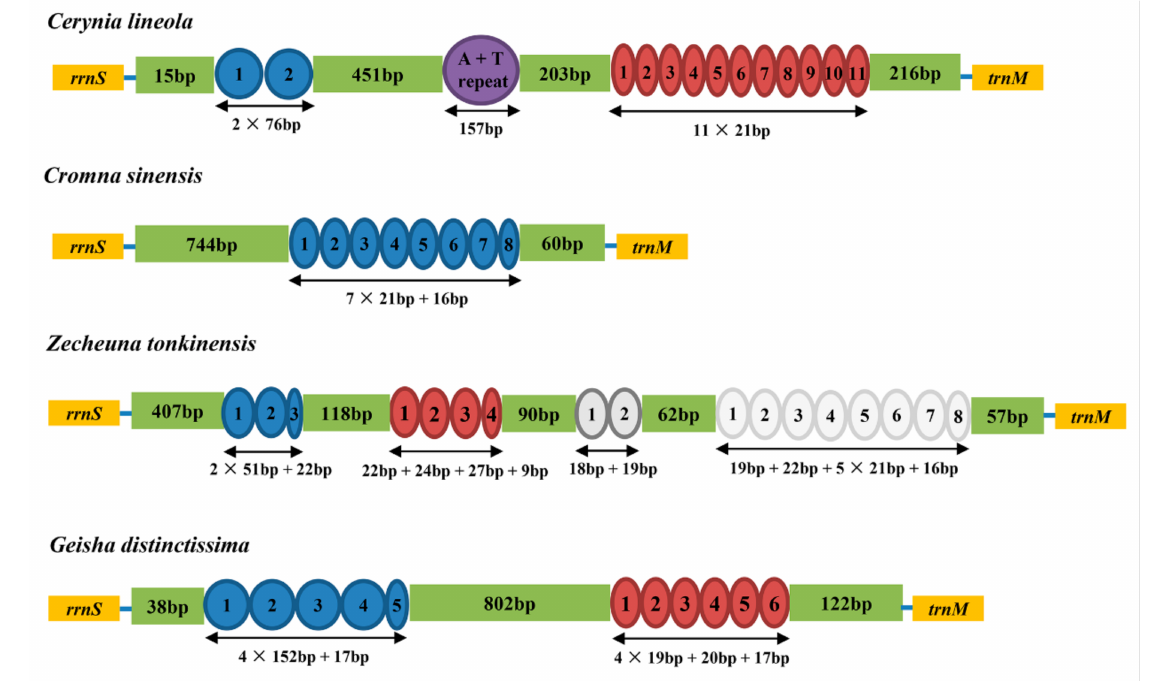
Figure 3. Organization of the control region in Flatidae mitogenomes. The blue, red, and gray ovals indicate the tandem repeats; the non-repeat regions are shown with green